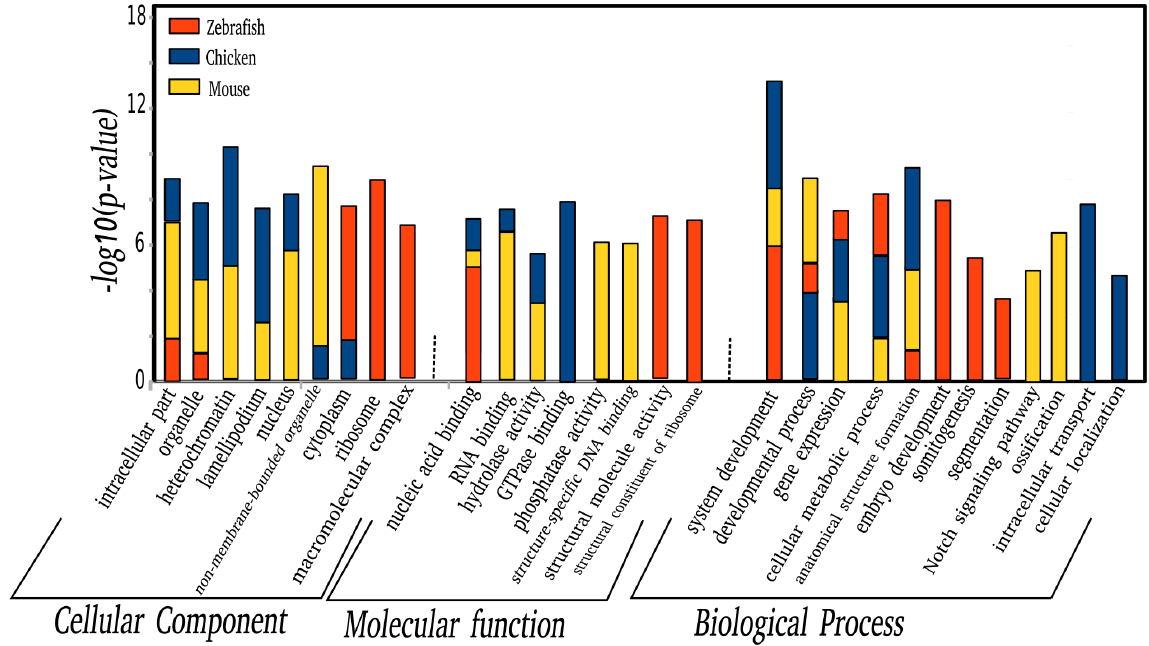
Fig 4. Gene Ontology analysis of the candidate cyclic genes with one peak of expression during mouse, chicken, and zebrafish somitogenesis. Shown are the top three GO terms for each species. The analysis was done using DAVID, an online set of tools for functional analysis of co-regulated genes. Only GO terms containing at least 5 of the input genes and a q-value (Benjamini corrected p-value) < 0.05 were